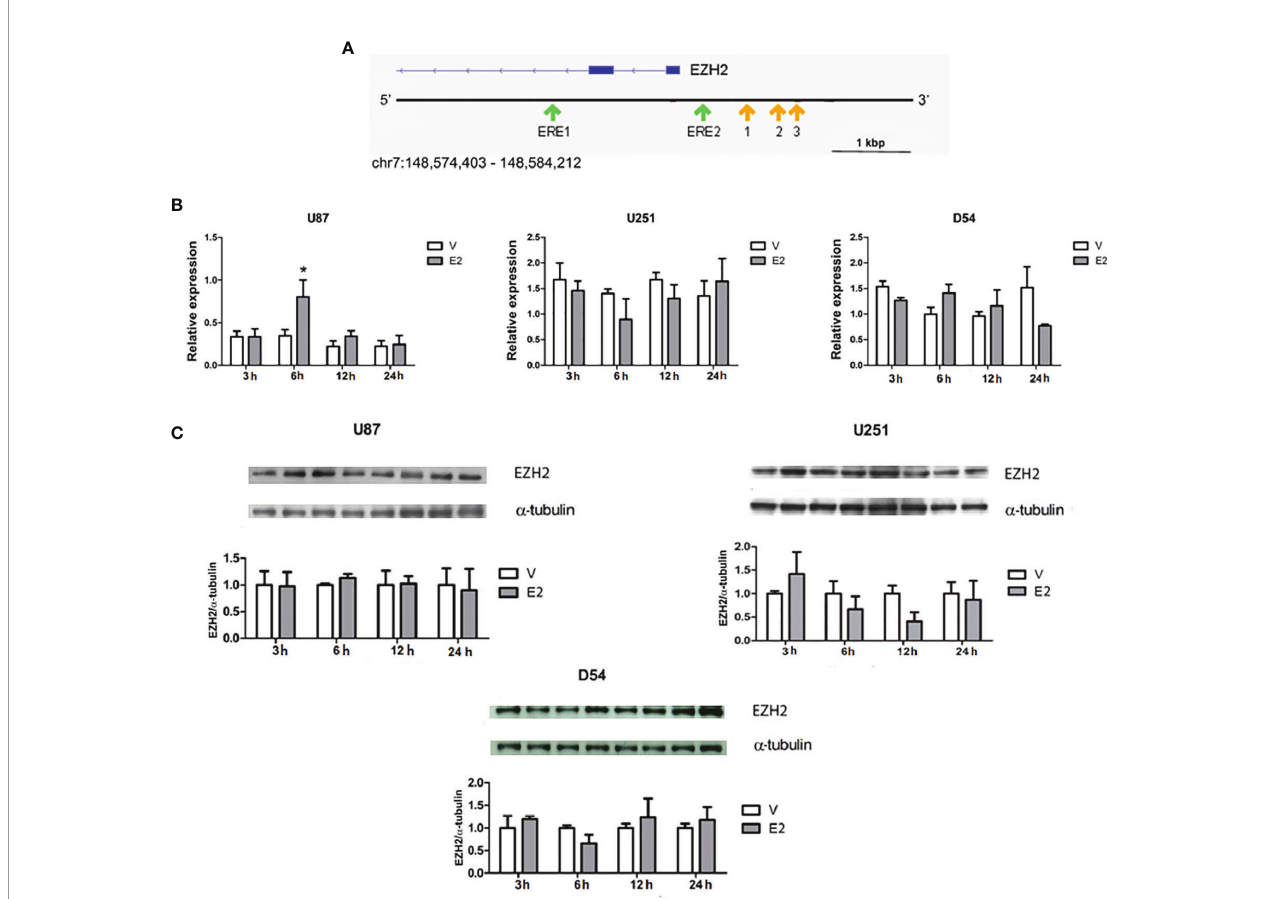
FIGURE 2 | E2 effect on EZH2 expression. (A) Schematic representation of the EZH2 gene is depicted in blue. The locations of EREs predicted by an in silico analysis are marked with green arrows. The analysis was performed on three different platforms (JASPAR, HOCOMOCO, and HOMER). A potential binding site was considered those predicted by two or more databases with a score value of 9 or higher and p < 0.05. Yellow arrows point to the binding sites previously described (22). Scale bar =1 Kbp. (B) EZH2 expression was quanti fi ed by RT-qPCR after cell treatments with E2 (10 nM) or V (0.02% CDX) for 3, 6, 12, and 24 h. Relative expression of EZH2 mRNA was calculated by the 2 DD Ct method using 18S ribosomal RNA as a reference gene. *p < 0.001 vs. V. Results are presented as mean ± S.E.M. n = 3. (C) E2 effect on EZH2 content was also evaluated by Western blot. Densitometric analysis and corresponding representative images of EZH2 bands are shown. Each bar represents the mean ± S.E.M, n = 4.